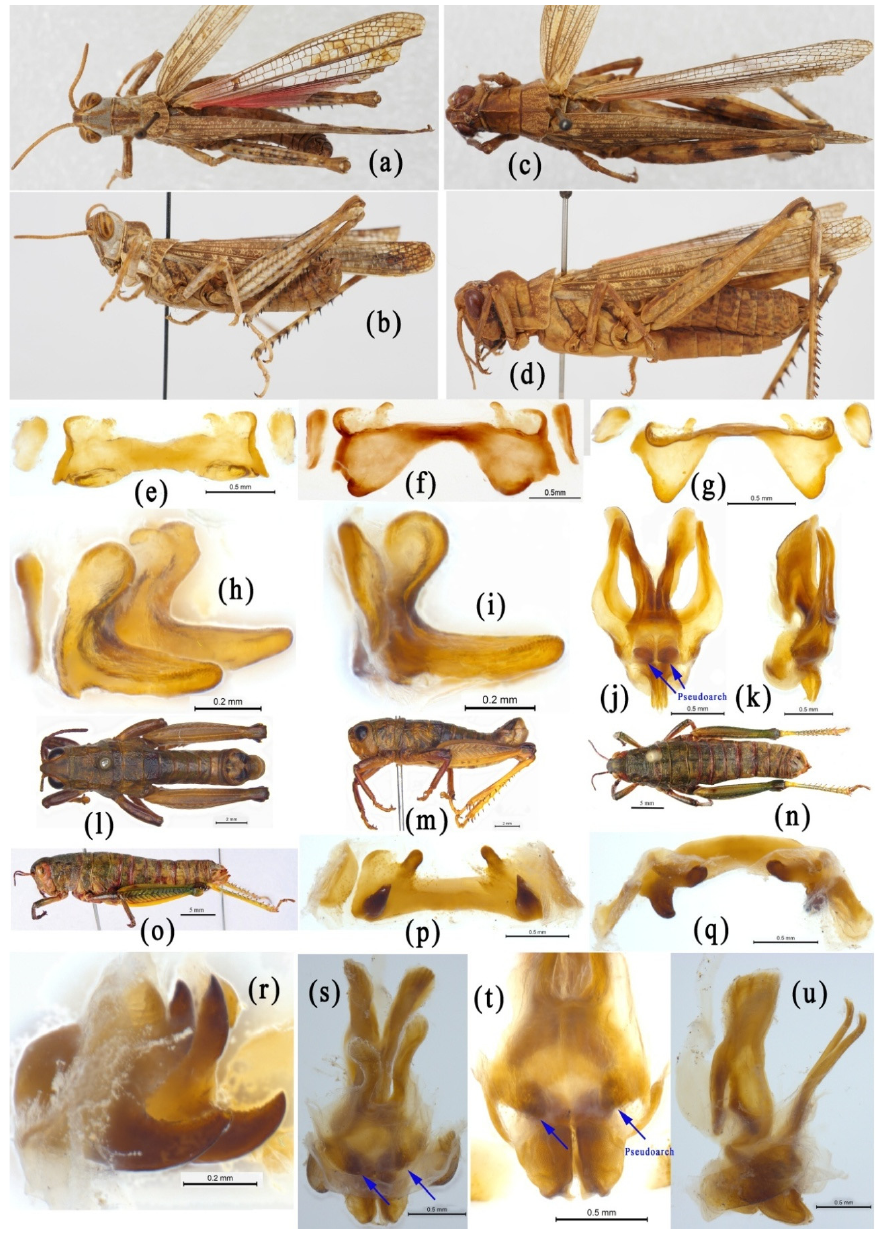
Figure 6. Morphological characters of Dericorys annulata and Conophyma zhaosuensis . ( a – k ) Dericorys annulata . ( a , b ) Male habitus. ( c , d ) Female habitus. ( e – i ) Epiphallus in dorsal, dorsofrontal, frontal, dorsolateral and lateral views. ( j , k ) Phallic complex in dorsal and lateral views. ( l – u ) Conophyma zhaosuensis . ( l , m ) Male habitus. ( n , o ) Female habitus. ( p – r ) Epiphallus in dorsal, frontal and dorsolateral views. ( s – u ) Phallic complex in dorsal and lateral views. The blue arrows indicate the pseudoarch.